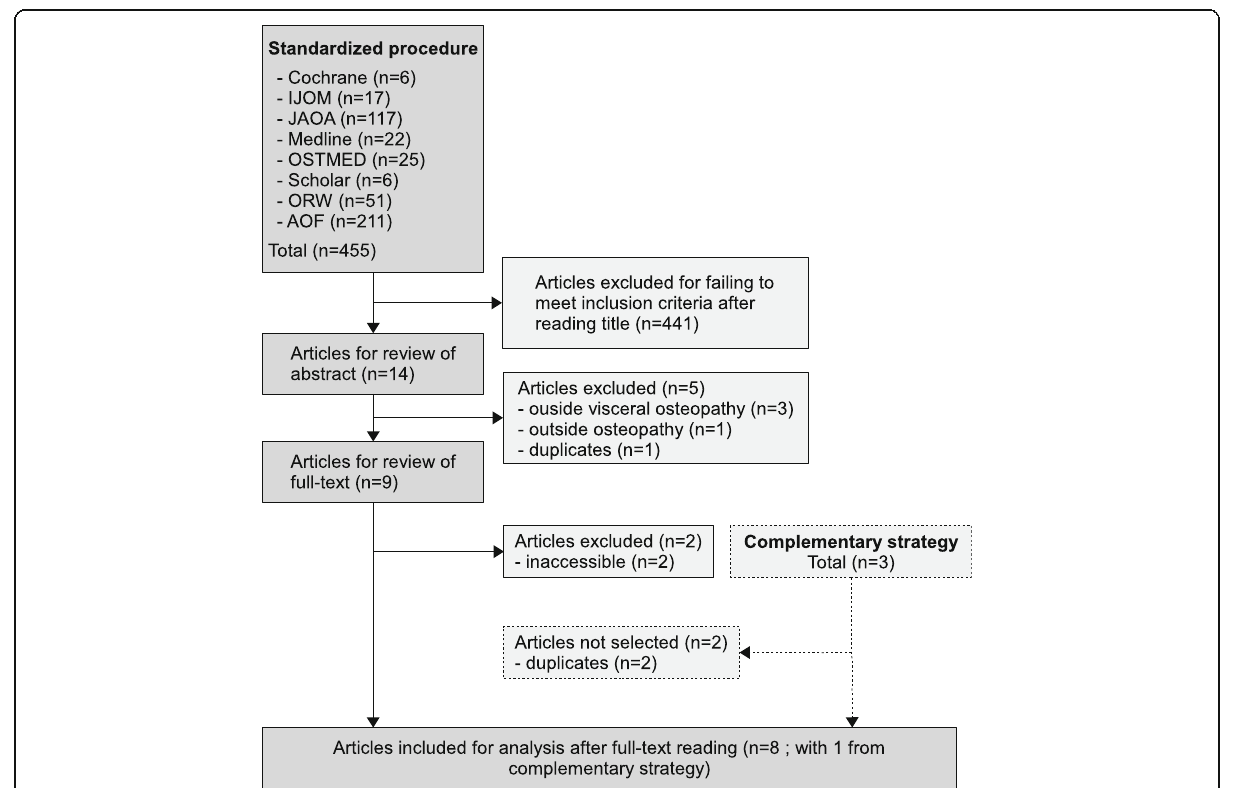
Fig. 1 Flow chart of the study selection process for the systematic review of studies dealing with the reliability of diagnosis in the field of visceral